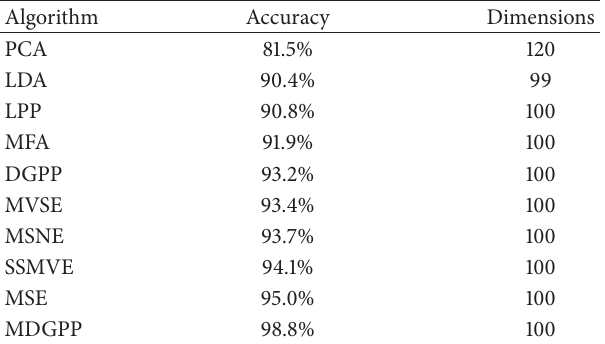
Table 1: Comparisons of recognition accuracy on the AR database.